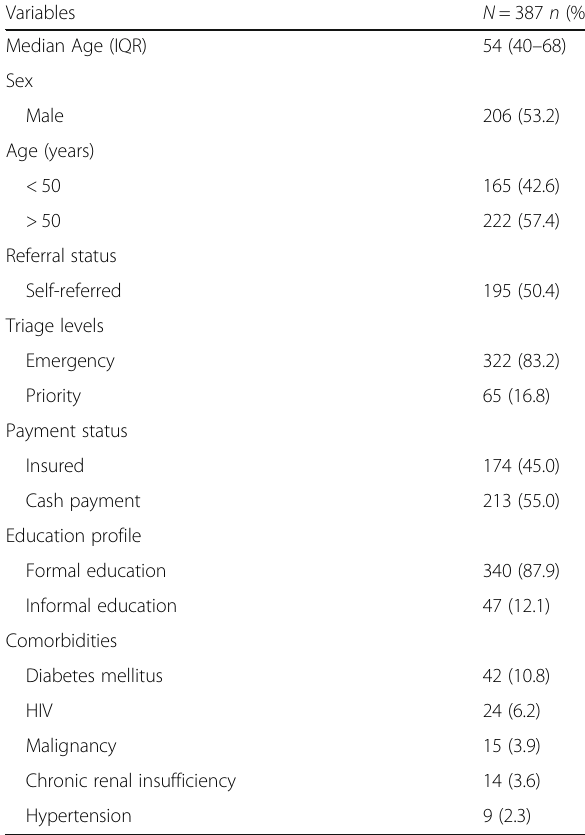
Table 1 Patients demographics characteristics